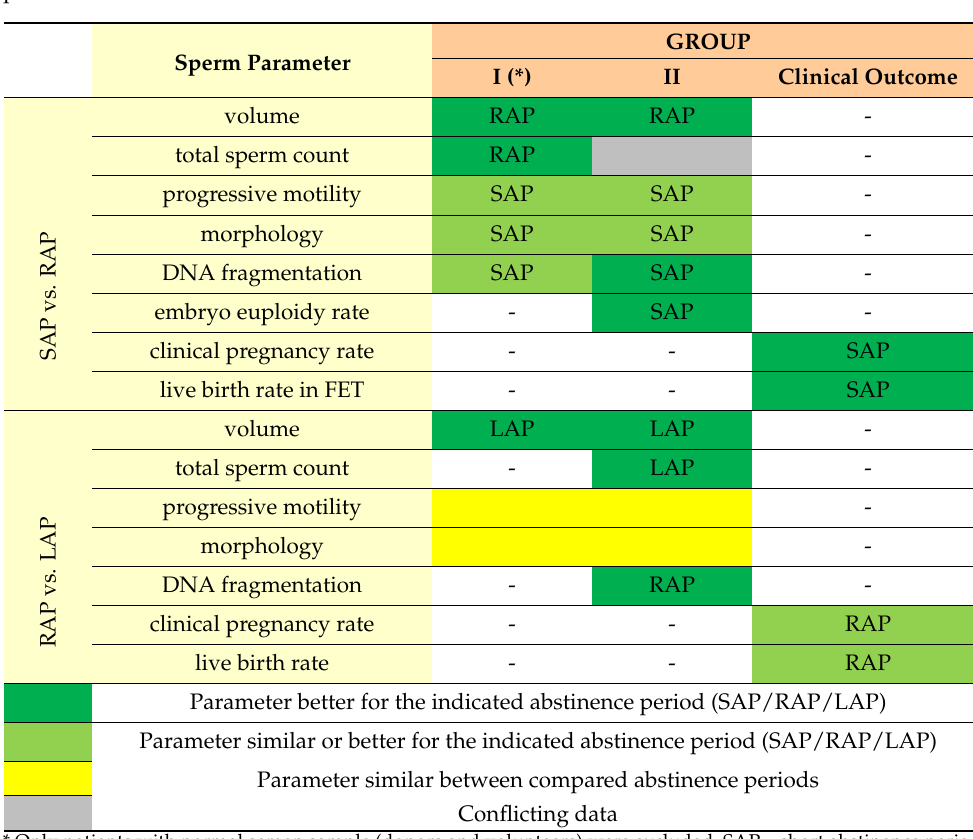
Table 2. Comparison of sperm parameters and clinical outcomes after different abstinence times in patients.